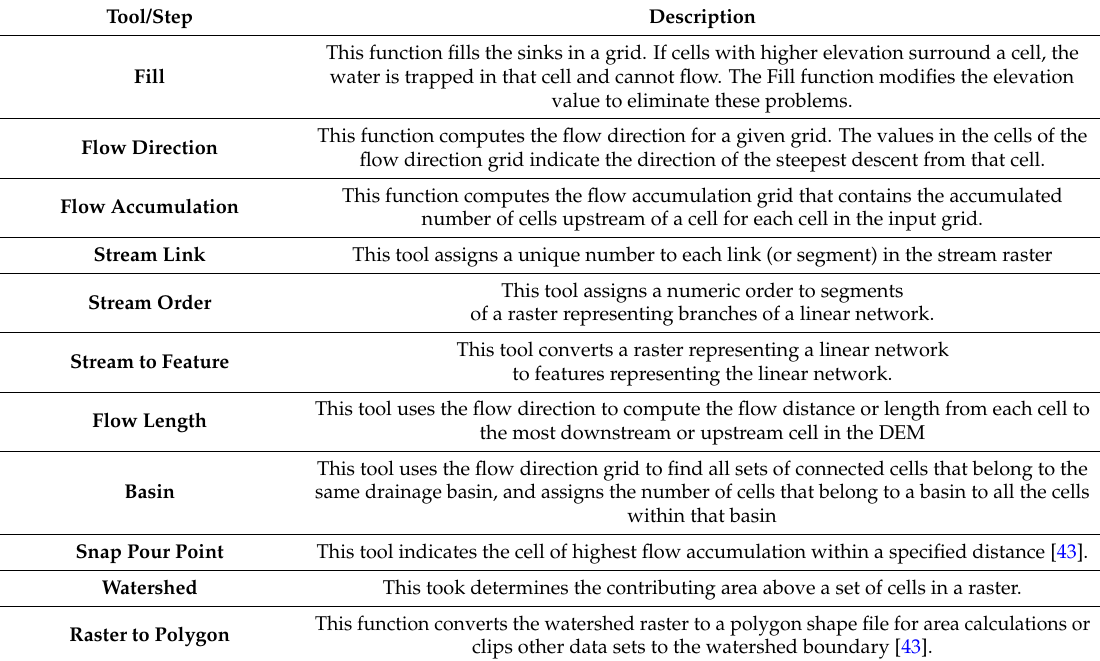
Table 1. The steps used to get watershed and water stream related information from DEM